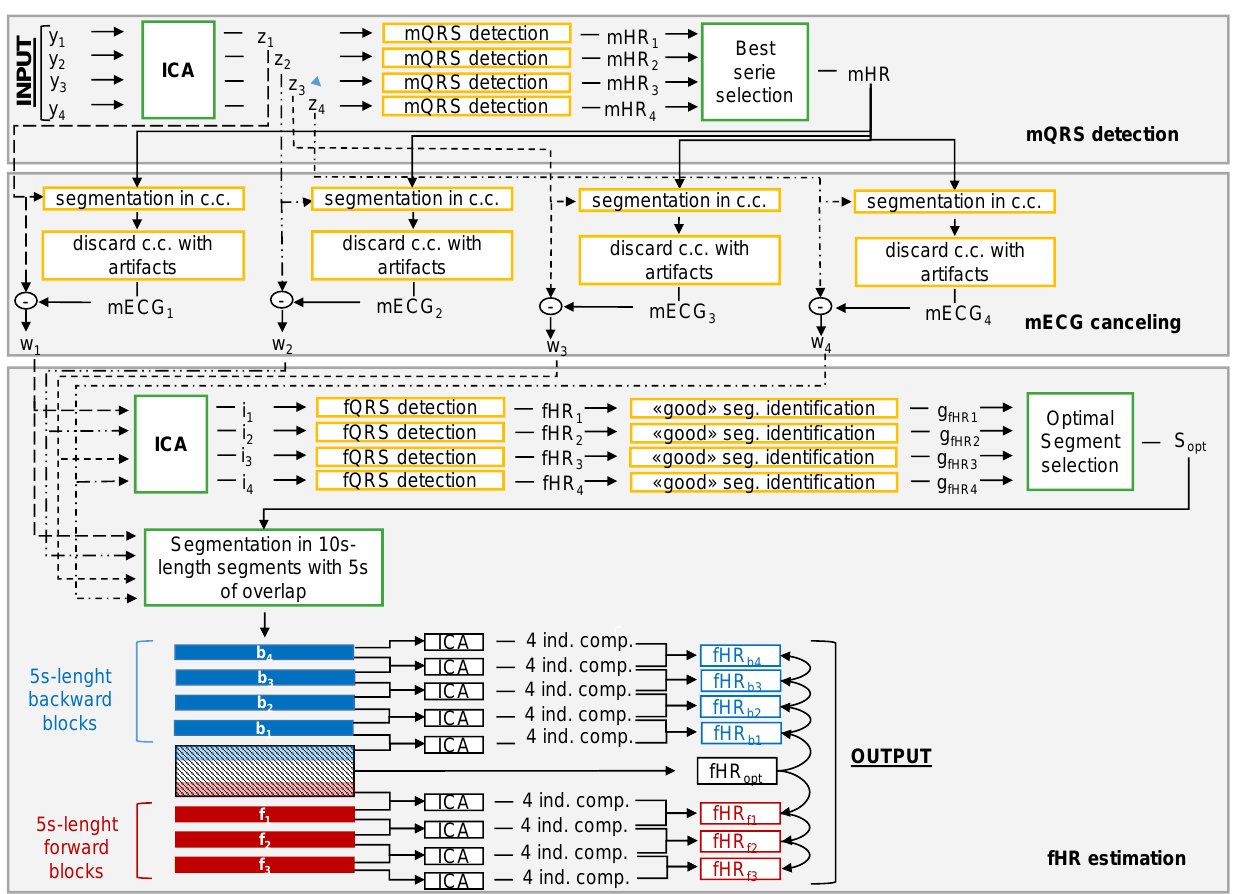
Figure 6. Block diagram of the steps (mQRS detection, mECG canceling and fHR estimation) of the main processing stage. The input is the matrix Y , which contains the bipolar measurements obtained after the pre-processing stage. The output is the fHR estimation. For the yellow blocks, only 1 element is involved; on the contrary, for the green blocks, all the elements are